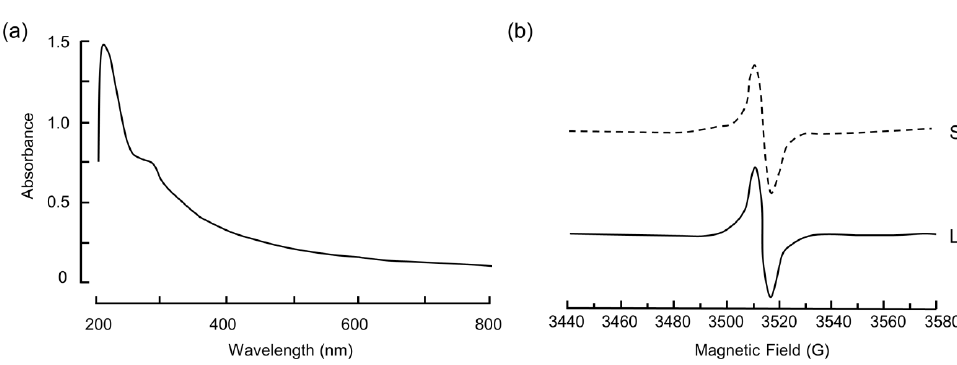
Figure 3. ( a ) UV-vis absorption spectra of BSF-Eumel in PBS, pH 7.4. ( b ) EPR analysis of BSF-Eumel at the solid state (S) and as PBS solution (L).